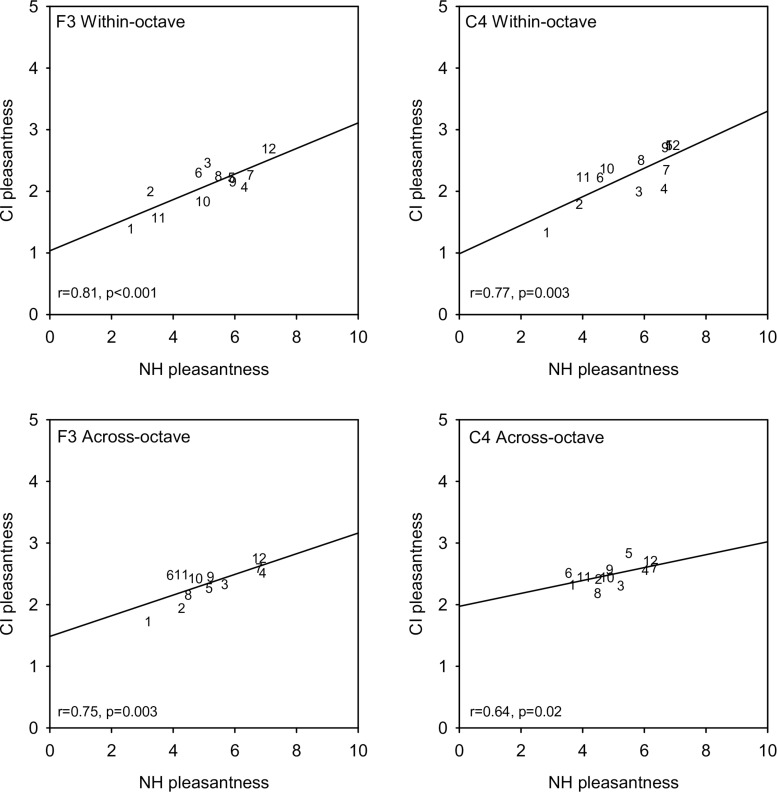
Mean CI-only pleasantness ratings (across subjects) as a function of mean NH-only ratings. Data for the F3 and C4 root notes are shown in the right and left columns, respectively. Data for within- and across-octave intervals are shown in the top and bottom rows, respectively. Note that the range for the CI-only ratings in half of that for the NH-only ratings. Interval size is indicated as numbers in each panel. The diagonal lines show linear regression fits to the data; r- and p-values are shown for each regression.